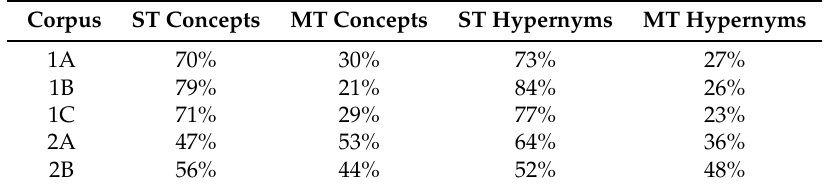
Table 3. Multi-token concepts and hypernyms across the corpora: MT stands for “multi-token” and ST stands for “single-token”.